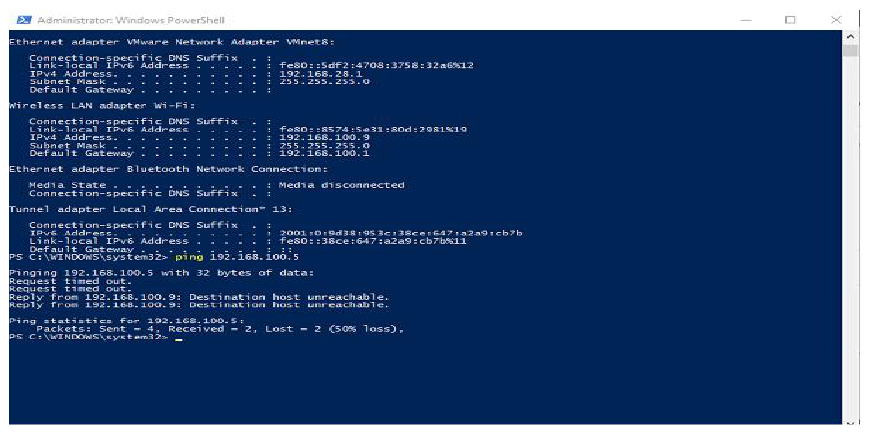
Figure 7 – Data on the attacked computer Рис . 7 – Данные на взломанном